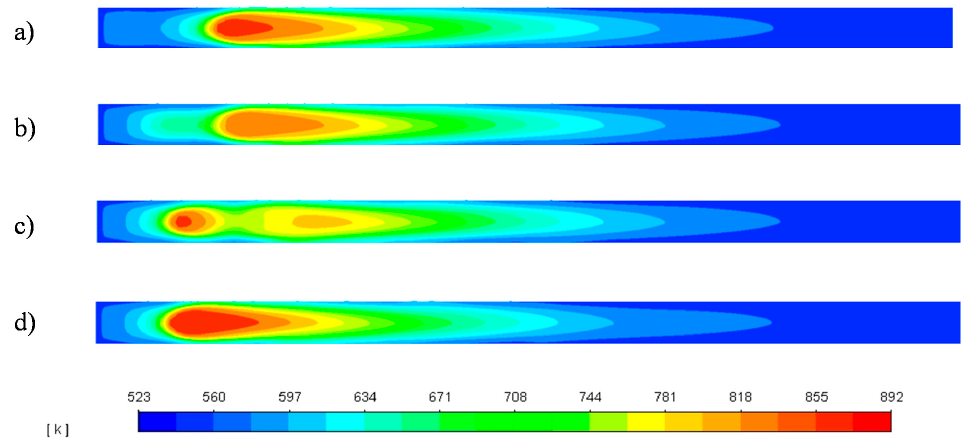
Figure 8. Temperature contours in the hot-spot relevant zone after a 20 K step-rise in the feed gas (523 K to 543 K) at t = ( a ) 10 s, ( b ) 20 s, ( c ) 30 s, ( d ) 120 s from disruption.